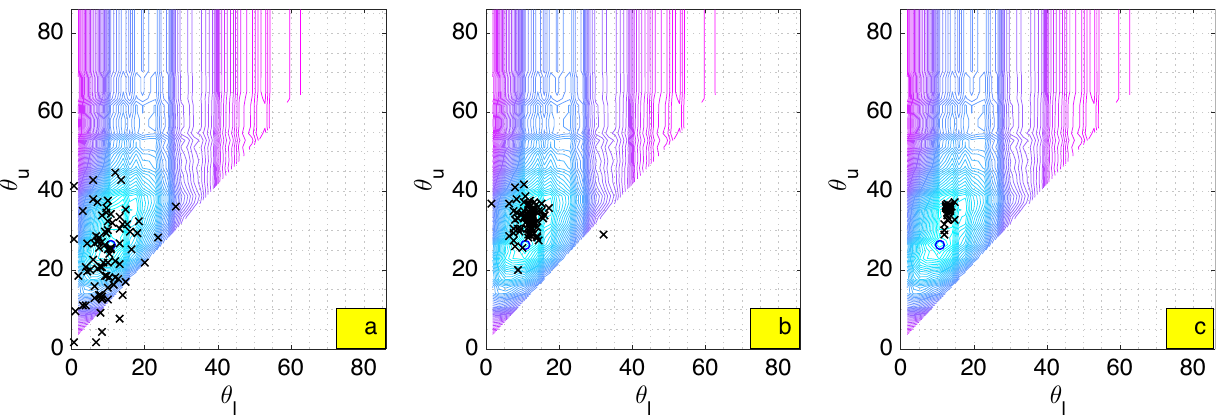
Figure 7. Computation of optimal barriers (θ l , θ u ) ≈ ( 13.3645, 36.0597 ) for the clustering. Blue circle encodes the optimal barriers found by the brute-force computations on the 50 × 50 grid. The figures show the evolution of the locations of 100 players (black × ) converging to an optimal solution that does not overlap with the grid: